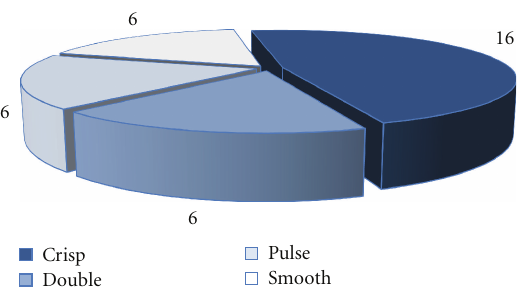
Figure 3: Most preferred haptic feedback e ff ect